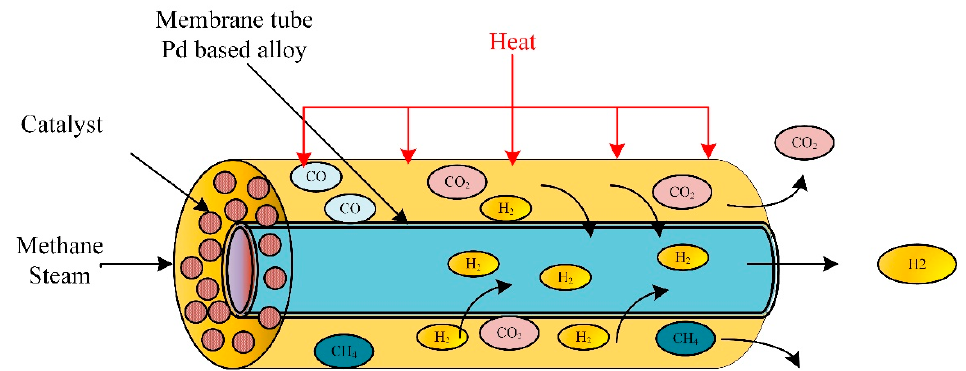
Figure 4. Membrane-based methane steam reforming for hydrogen production.